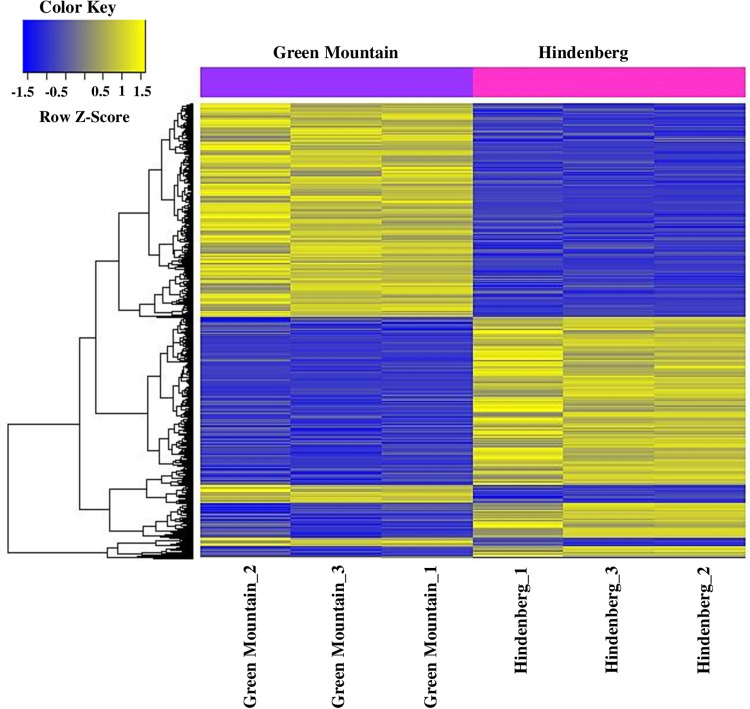
Hierarchical clustering heat map showing differentially expressed genes in triplicated samples of the scab susceptible cultivar Green Mountain and the resistant cultivar Hindenburg.Complete linkage and Euclidian distance were used as a measure of similarity to display expression patterns of DEGs with absolute fold change ≥2. Each row corresponds to a gene and each column corresponds to an individual replicate for each cultivar. The cultivar GM and HB are color-coded in purple and magenta, respectively. The normalized expression z-score scale is indicated by the color key in the top left corner. Blue, down-regulated genes; Yellow, up-regulated genes.